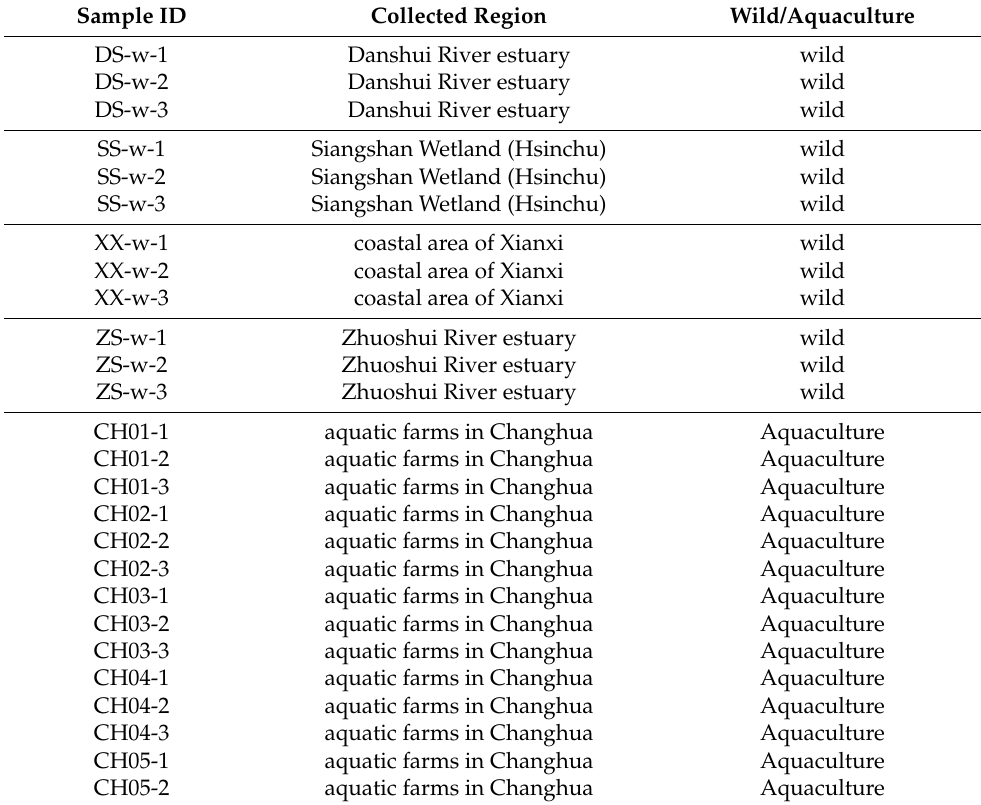
Figure 1. Sampling sites along the coastal area of Taiwan. Table 1. The clam samples for analysis.